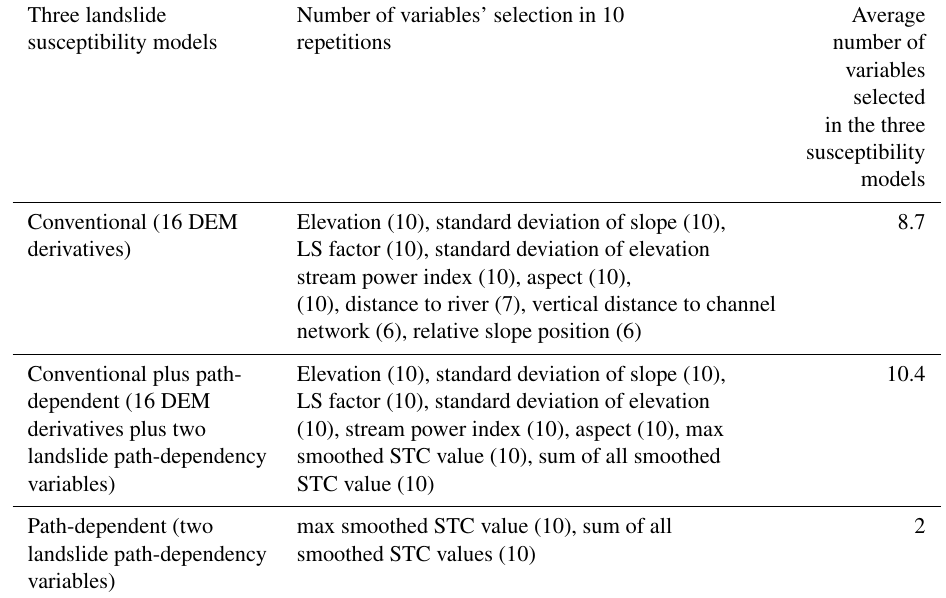
Table 2. Selection of independent variables in conventional, conventional plus path-dependent and purely path-dependent landslide suscep- tibility modelling. Variables selected six or more times are shown. The numbers in brackets indicate how often variables were selected.